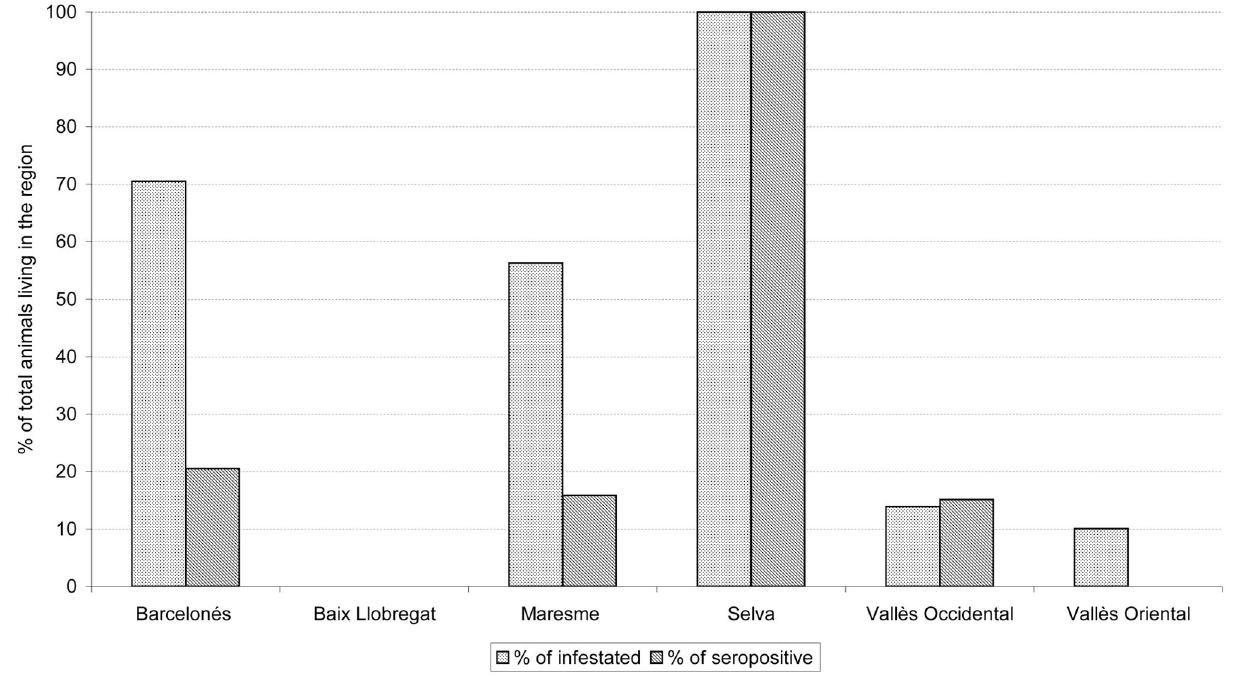
Figure 2. Geographical distribution: percentage of infested and seropositive cats compared to the entire population of each region. doi: